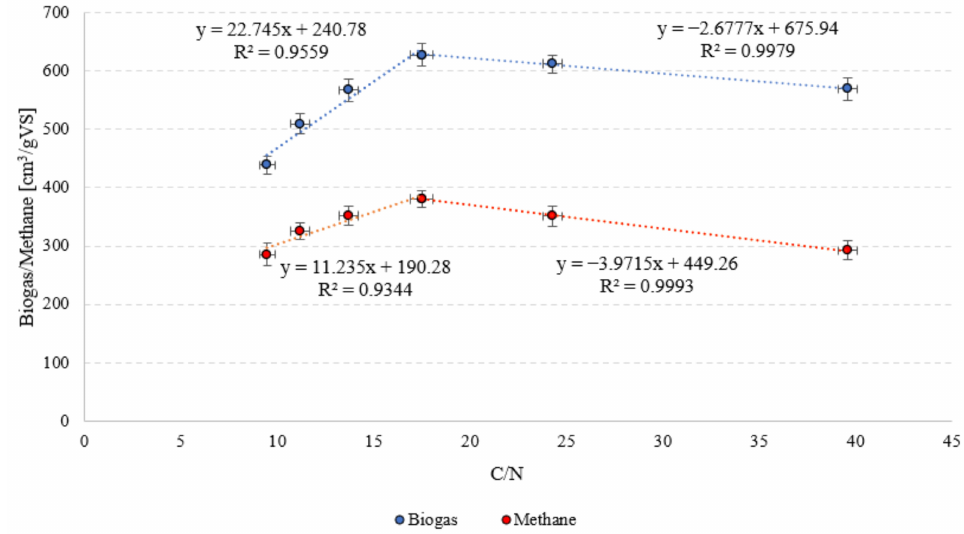
Figure 3. Correlations between biogas or methane yield and the C/N ratio.